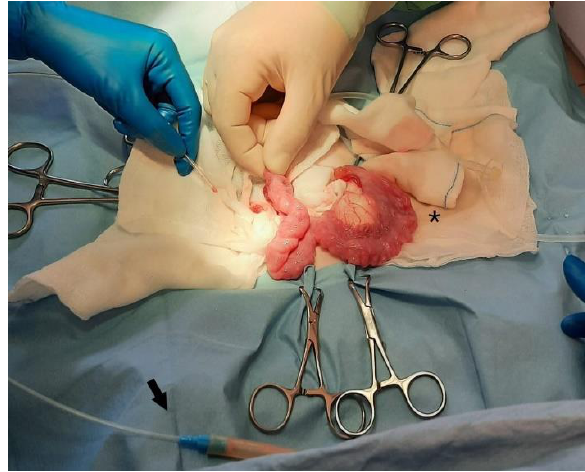
Figure 5. Detail of the size difference between left drained horn (*), and right, still to be drained. The arrow indicates the connection between the catheter and the surgical aspirator.